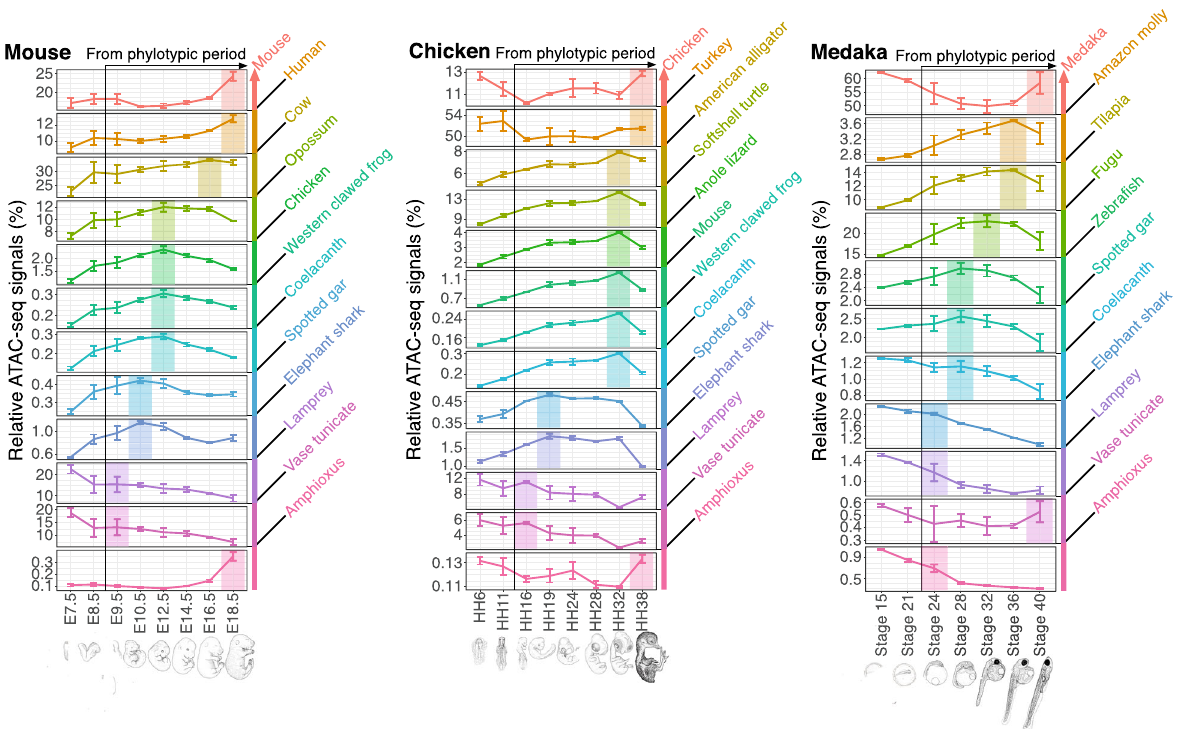
Fig. 3 Transition of developmental stages with the maximum evolutionarily categorized chromatin accessibility during vertebrate embryogenesis. For each developmental stage in three vertebrate species (mouse, chicken, and medaka), the percentages on the vertical axis represent the summed signal intensity for each evolutionary category of ACRs divided by the total signal intensity for all categories (relative ATAC-seq signal). The color of each category indicates the estimated evolutionary age of the region (shown at right). In each graph, the developmental stages with the highest signal from the potential phylotypic period are highlighted in the corresponding colors, as is the range that showed a recapitulative pattern for unknown reasons. Error bars indicate the standard deviation of three biological replicates for each developmental stage. Changes in the relative ATAC-seq signals were statistically significant (Kruskal – Wallis rank sum test) in all cases, except for the vase tunicate category